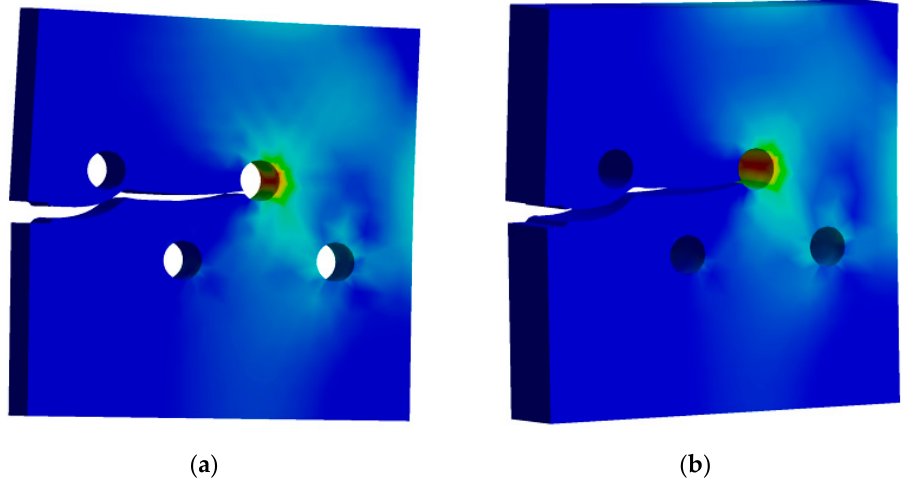
Figure 3. Predicted crack growth path: ( a ) 10 mm thickness, ( b ) 20 mm thickness.